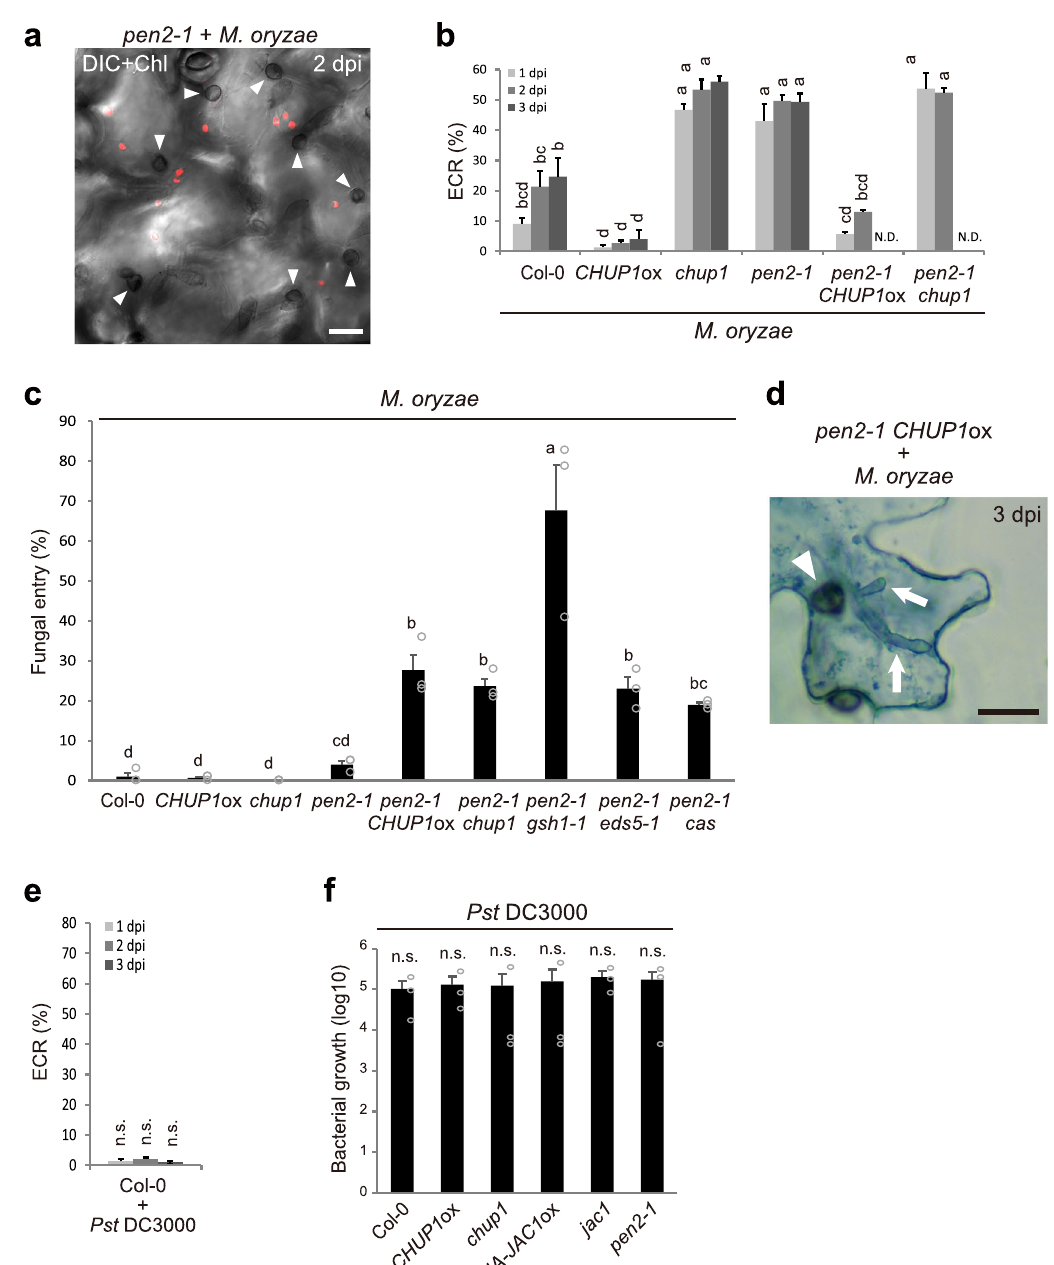
Fig. 9 The ECR contributes to preinvasive NHR against M. oryzae . a ECR after inoculation of M. oryzae . M. oryzae was inoculated onto cotyledons of pen2- 1 plants, and the ECR was investigated at 2 dpi. The chloroplasts were visualized based on chlorophyll auto fl uorescence. b Quanti fi cation of ECR against M. oryzae . ECR was investigated at 1, 2, and 3 dpi. A total of 100 cells in contact with the melanized appressorium were observed. N.D.: not determined due to damages of epidermal cell by fungal invasion. c Entry rate of M. oryzae into epidermis at 3 dpi. A total of 100 melanized appressoria were investigated. d Epidermal cell death caused by appressorium-mediated entry of M. oryzae at 3 dpi. The inoculated plants were subjected to TB staining and observed microscopically using x40 objective lens. The arrowheads and arrows indicate melanized appressoria and invasive hyphae, respectively. Scale bar, 20 µ m. The means and SE were calculated from three independent plants. Means not sharing the same letter are signi fi cantly different ( P < 0.05, one-way ( c ) or two-way ( b ) ANOVA with Tukey ’ s HSD test). e Quanti fi cation of ECR against Pseudomonas syringae pv. tomato ( Pst ) DC3000. Cotyledons of Col-0 were drop-inoculated with Pst DC3000, and ECR was investigated at 1, 2, and 3 dpi. A total of 100 epidermal pavement cells were observed. The means and SE were calculated from three independent plants. f Growth of Pst DC3000 in Arabidopsis cotyledons. Cotyledons of indicated Arabidopsis were drop- inoculated with Pst DC3000, and incubated for 4 days. The number of bacteria in eight cotyledons obtained from four independent plants was plotted on a log10 scale. The means and SE were calculated from three independent experiments. n.s. not signi fi cant (* P < 0.05, one-way ( f ) or two-way ( e ) ANOVA with Tukey ’ s HSD